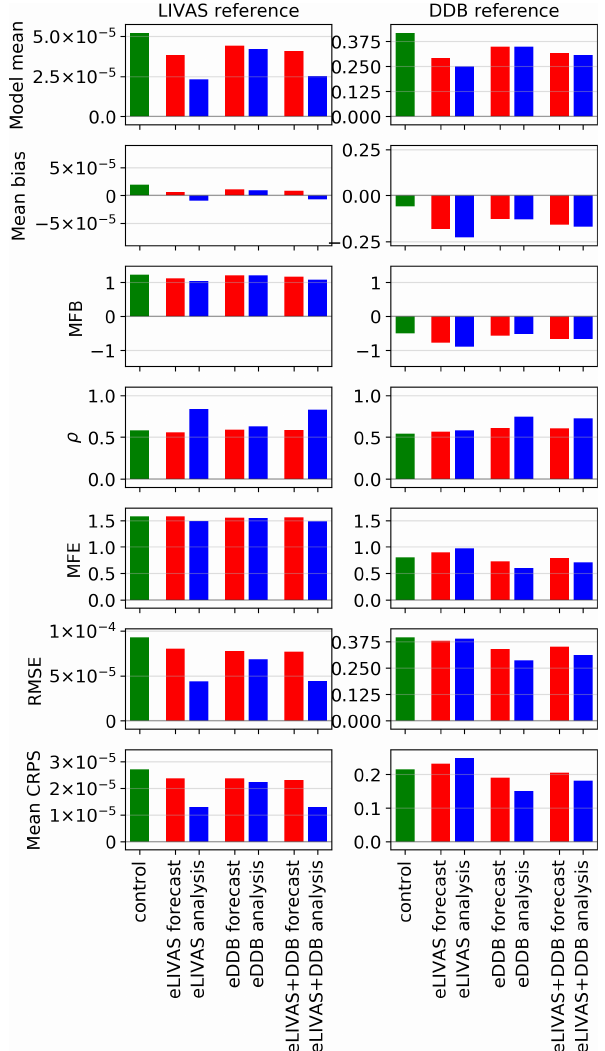
Figure 5. Verification scores against LIVAS dust extinction coef- ficient in the left column, scores against the DDB DOD dataset in the right column. Scores of the control run are shown in green, fore- casts in red, and analyses in blue. In the left column, panels of model mean, mean bias, RMSE, and mean CRPS have units of m − 1